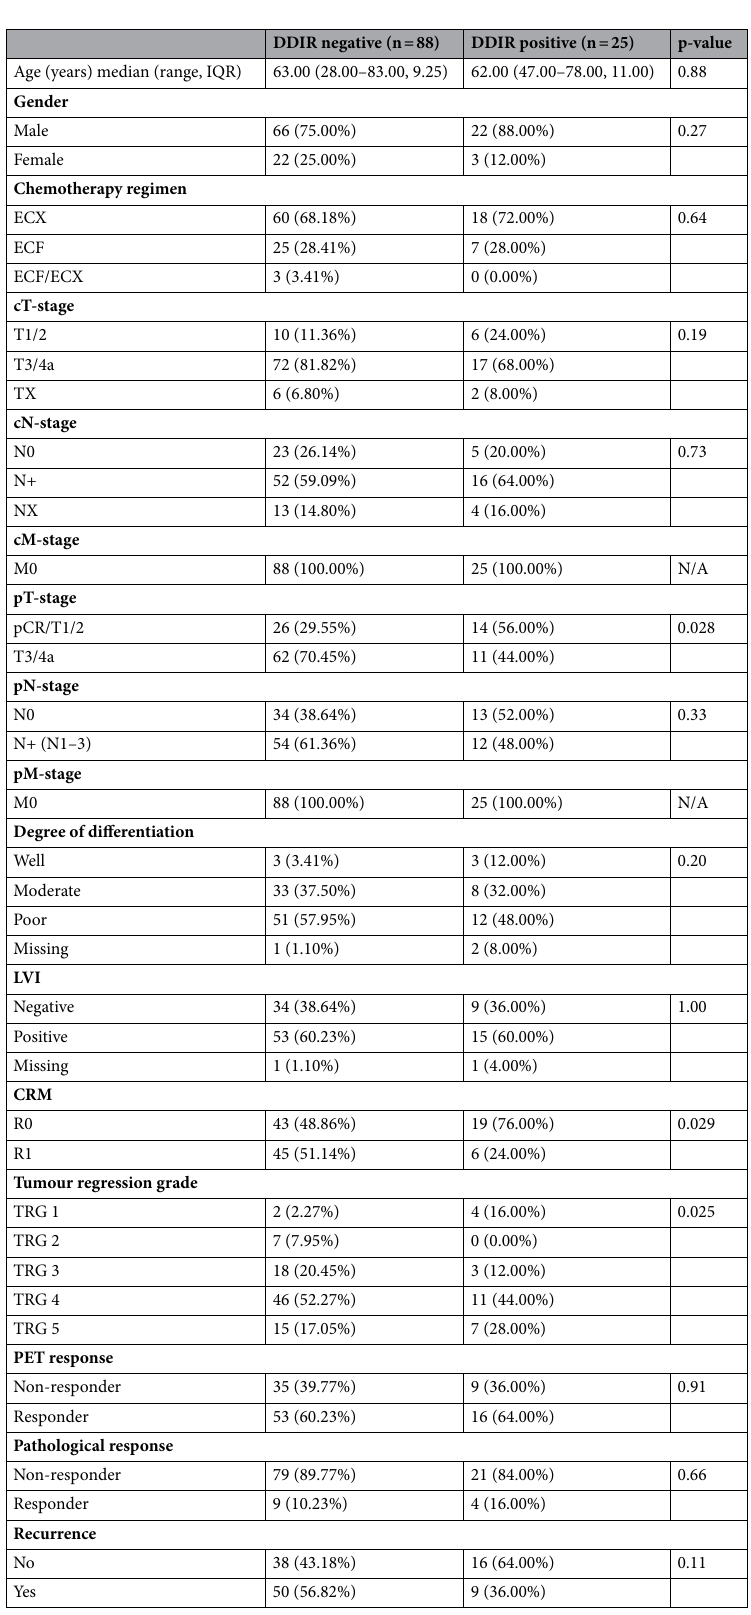
Table 1. Baseline characteristics of patient cohort. ECX epirubicin, cisplatin and capecitabine, ECF epirubicin, cisplatin and 5-fluorouracil; c clinical, p pathological, TX T-stage not assessed, NX N-stage not assessed, GX grade of differentiation not assessed, pCR complete pathological response, N/A not applicable, LVI local vascular invasion, CRM circumferential resection margin, TRG tumour regression